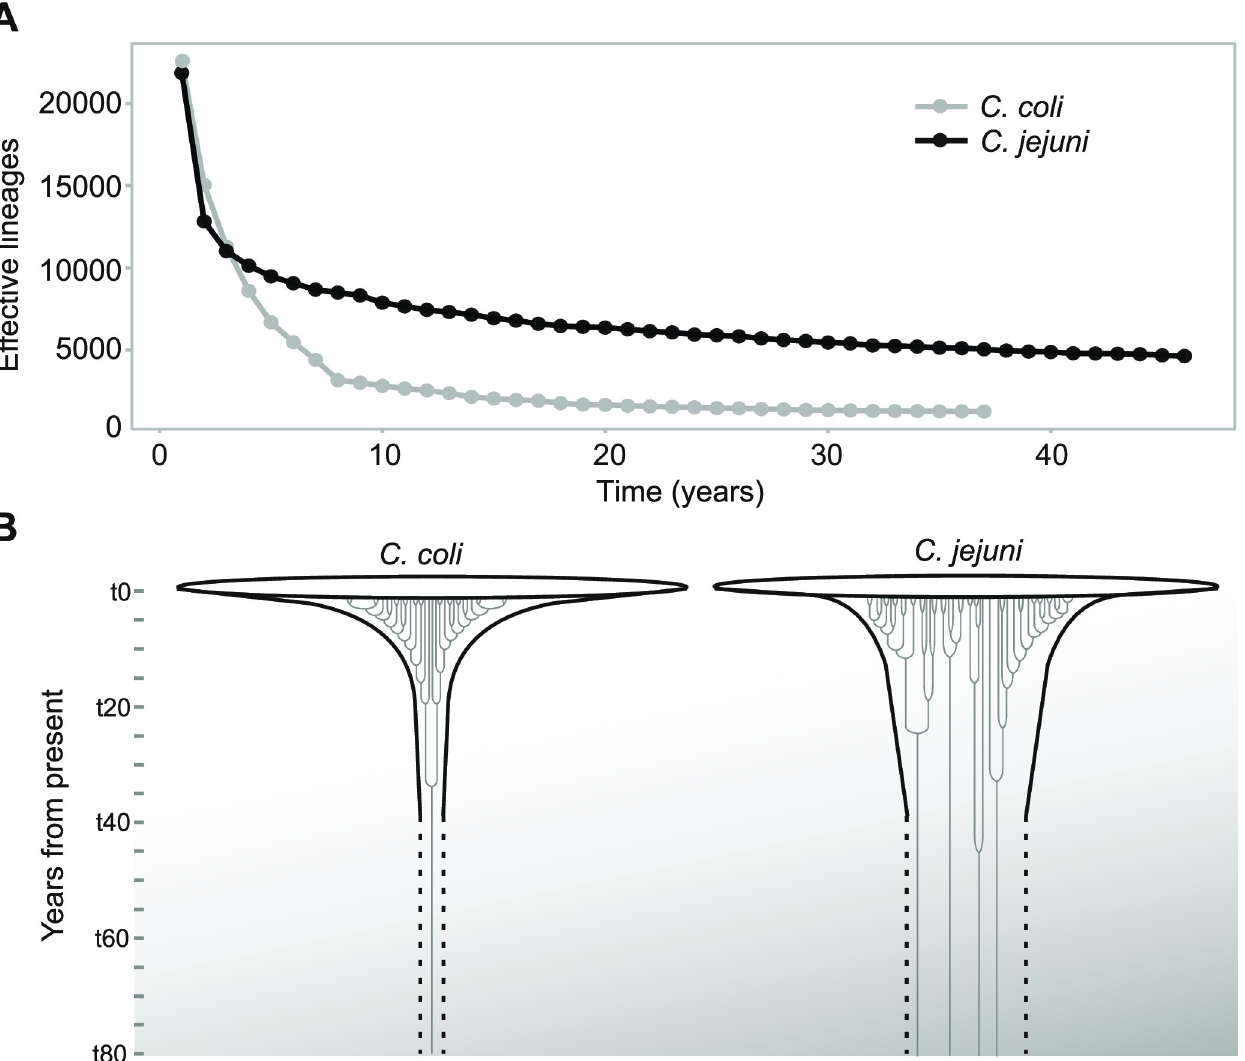
Fig 5. Lineage expansion in C . jejuni and C . coli . (A) Number of effective lineages (y axis) at each time point within the sample time frame (x axis) for C . coli (grey) and C . jejuni (black). (B) Diagrammatic representation of lineage expansion in C . coli and C . jejuni showing contrasting lineage diversification